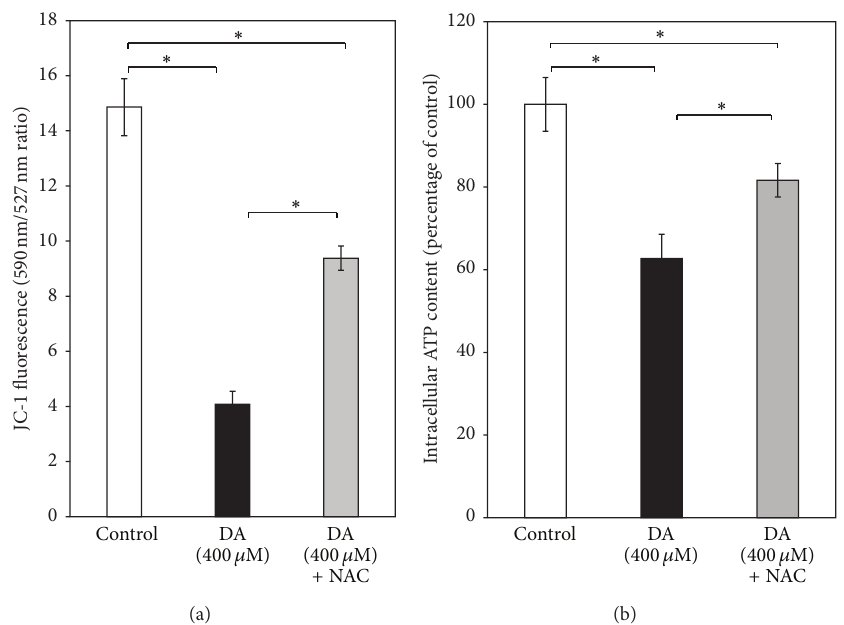
Figure 2: Effect of DA on mitochondrial functions in SH-SY5Y cells. SH-SY5Y cells were incubated without or with DA (400 𝜇 M) for 24 h in the absence or presence of NAC (2.5 mM) and (a) mitochondrial membrane potential and (b) intracellular ATP content were measured as described in Section 3. Values are the means ± SD of six observations. Statistically significant differences ( 𝑃 < 0.001 ) exist among the groups as shown by asterisks ( ∗ ) (in (a), 𝐹 (2, 15) = 353.56, 𝑃 < 0.001 ; in (b), 𝐹 (2,15) = 67.39, 𝑃 < 0.001